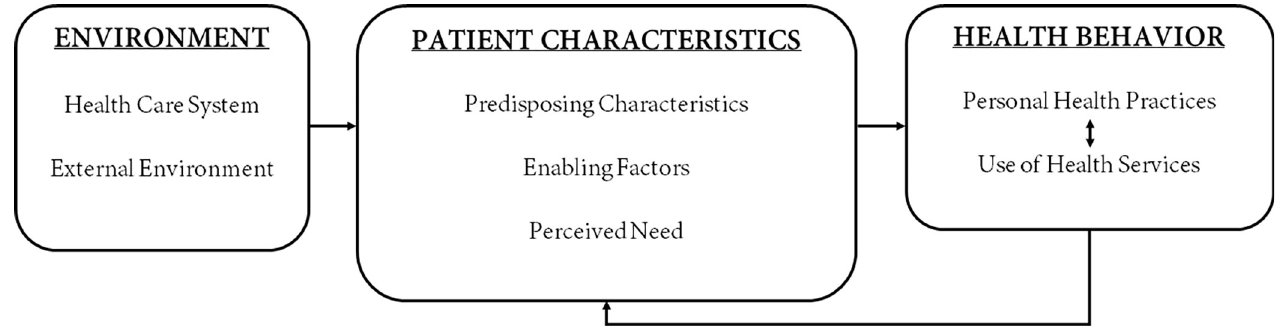
Fig 1. The Andersen’s behavioral model of health services use (adapted from Andersen)